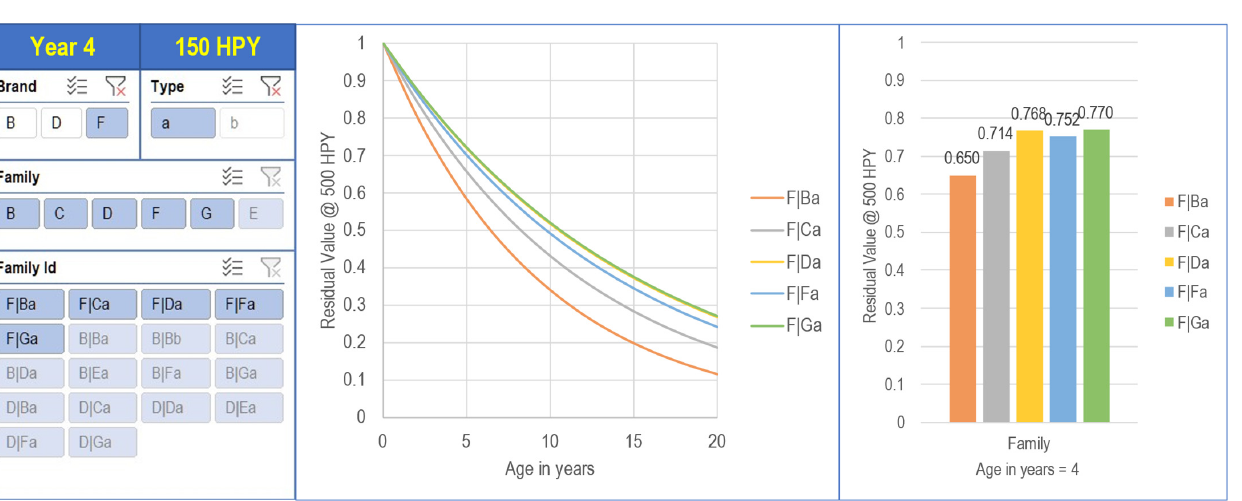
Figure 8. Residual value (value as new =1) comparison of Brand F combine families with 150 h per year (HPY).